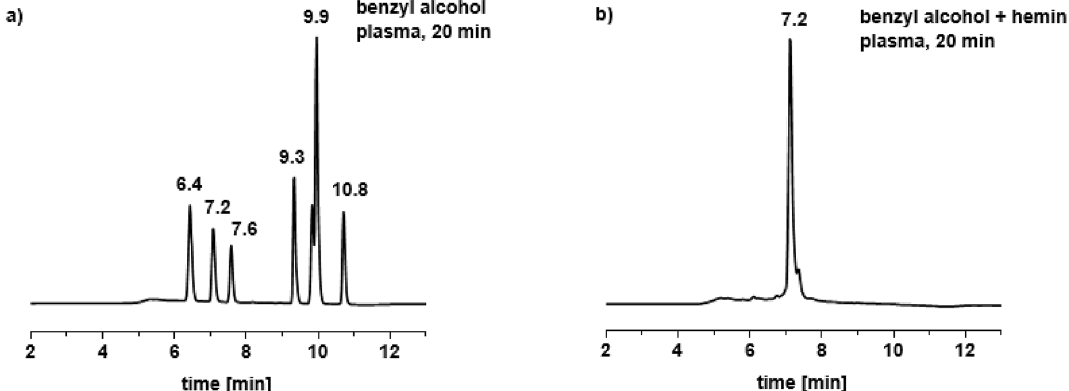
Figure 2. HPLC trace of benzyl alcohol after plasma treatment ( a ) without metal complex, ( b ) in the presence of complex B .